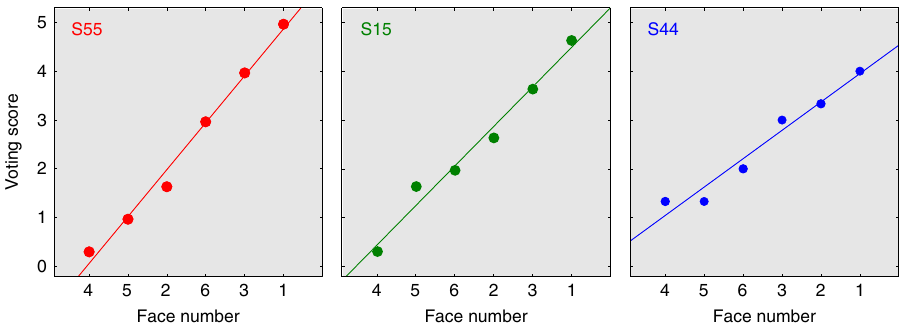
Fig. 5 Individual voting functions. Examples of voting functions for individual subjects. Receiver operating characteristics for the same subjects are displayed in Fig. 8, matched by color.